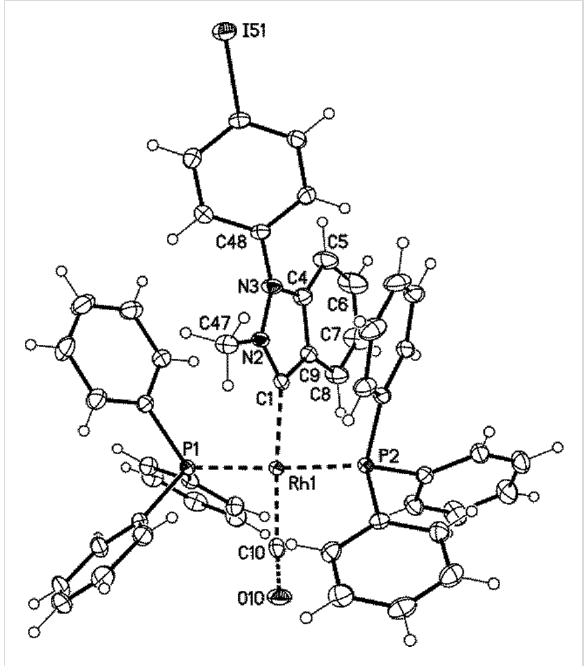
Figure 3: Structure of the cation of 15e , displacement parameters are drawn at 50% probability level.